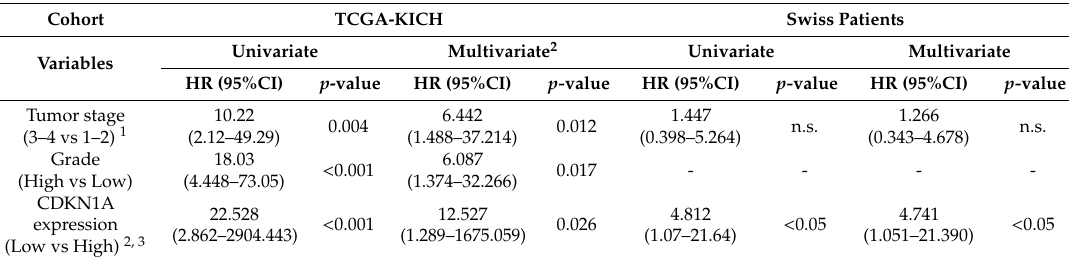
Table 2. Tumor stage, histological grading according to necrosis and / or sarcomatoid di ff erentiation, CDKN1A expression separated by the best separation cuto ff from FIREHOSE [24] mRNA data and overall survival in chromophobe renal cell